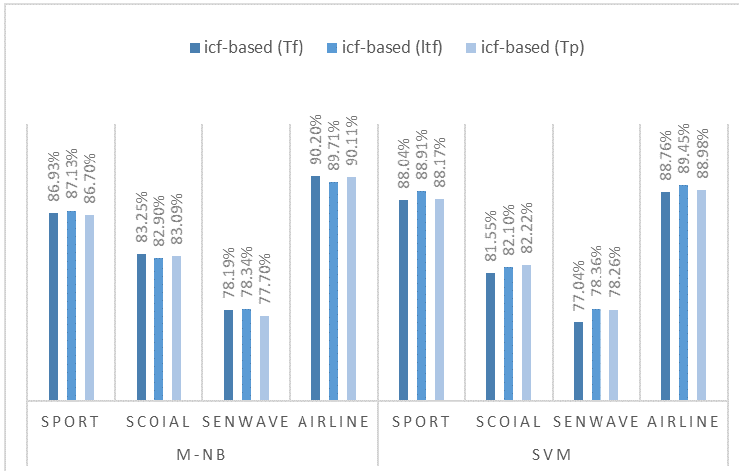
Figure 5. icf-based using different local factors.